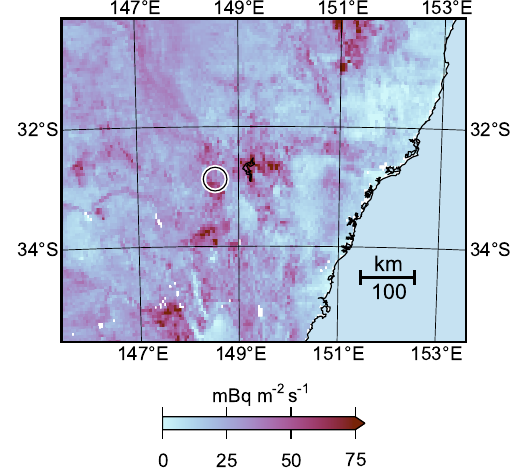
Fig. 1. The Baldry Hydrological Observatory (32.88 ◦ S, 148.54 ◦ E) and mean radon emissions (Griffiths et al.,